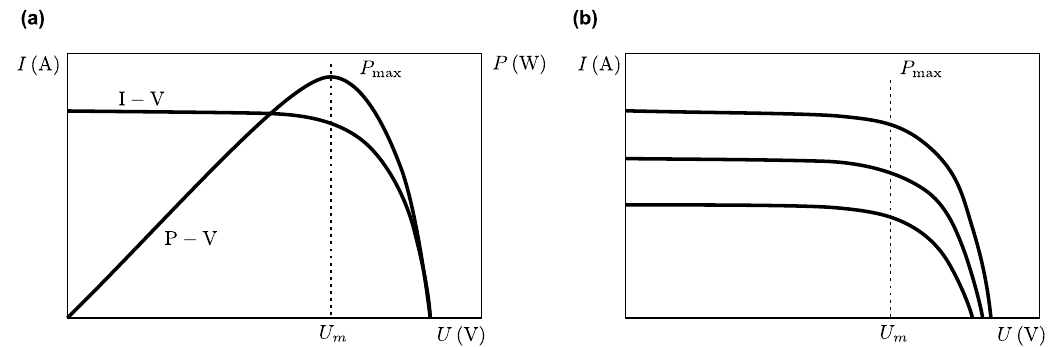
Figure 3. Current-Voltage (I-V) and Power-Voltage (P-V) characteristic curve of solar cells: ( a ) constant irradiance; ( b ) variable irradiance, adapted from